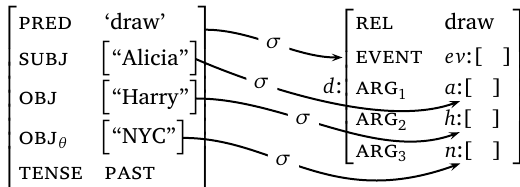
Structures and correspondences for Alicia drew Harry New York